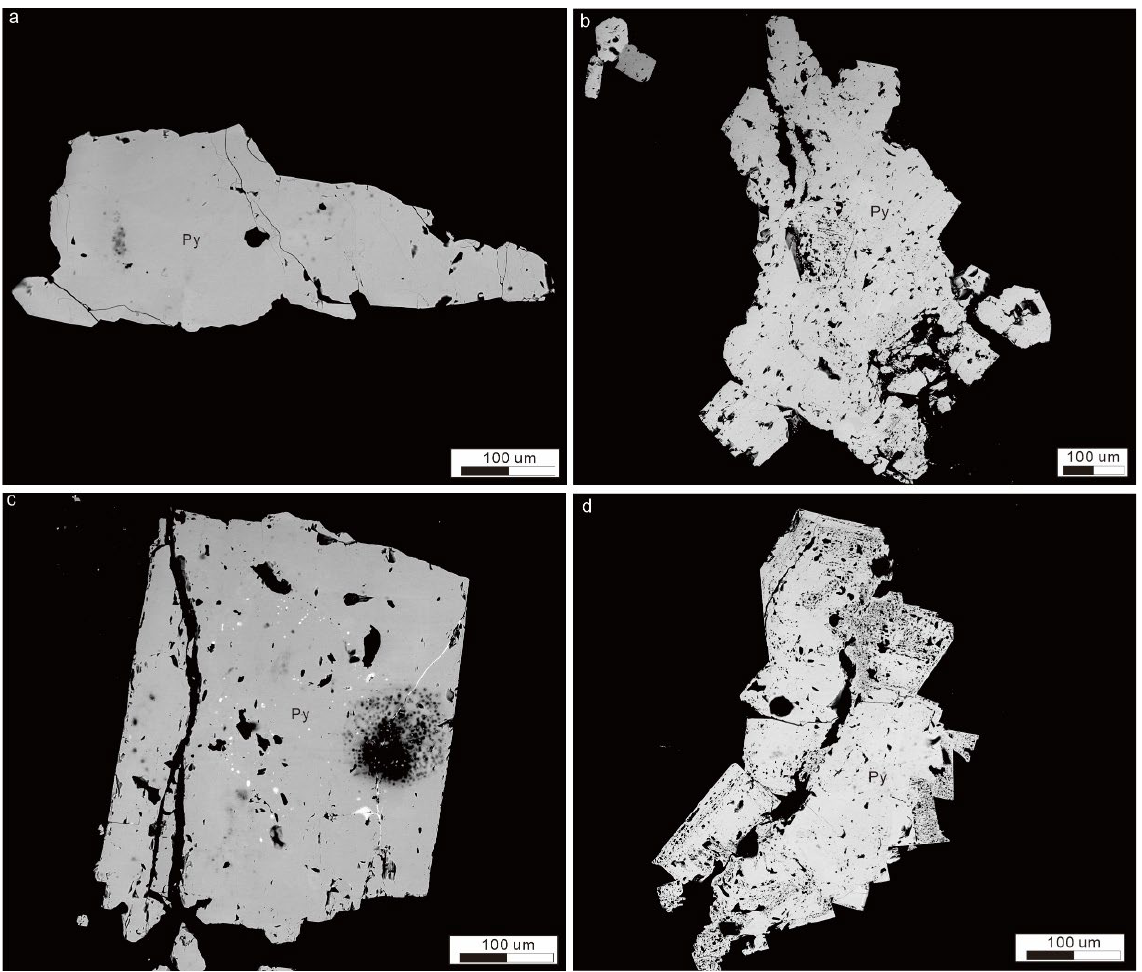
Figure 7. ( a – d ) Backscattered electron images showing the textural characteristics of Py1.